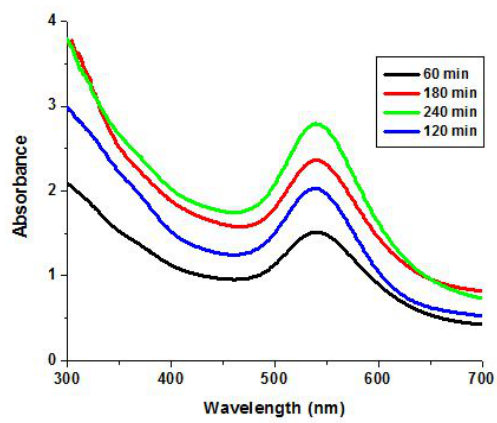
Figure 2. Change in absorption with the passage of time.